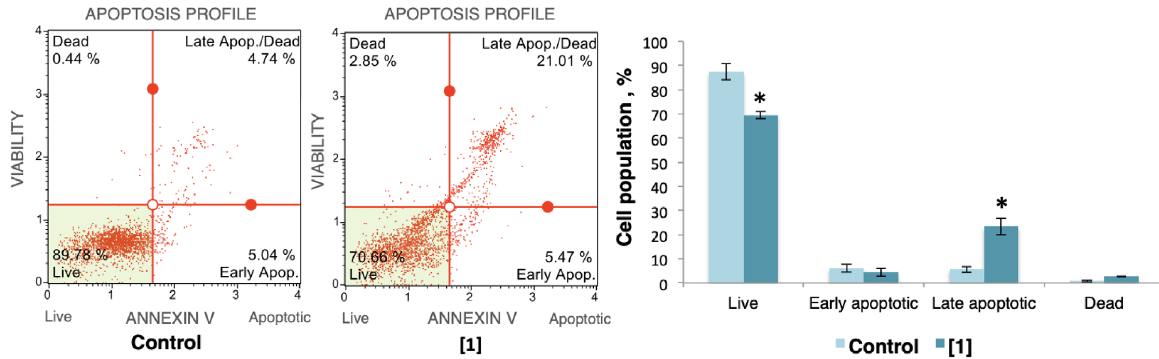
Figure 3. The results of the Annexin V binding assay. The cells were plated in a 12-well plate at a density of 2x10 5 cells/ml and treated with 3.432 mg/mL of hexane extract from the root [1] for 24 hr, and the apoptosis was detected by the Muse cell analyzer (Millipore). Nontreated cells were used as control. The apoptotic cells were determined by the Annexin V positivity based on phosphatidylserine exposure, and dead cells were determined by the nuclear dye 7-AAD (7-aminoactinomycin D) positivity. Four different cell population were enabled to examine by cytofluorometric separation on a Muse cell analyzer: non-apoptotic live (lower left (LL): 7-AAD negative, apoptosis negative), non-apoptotic dead (upper left (UL): 7-AAD positive, apoptosis negative), apoptotic live (lower right (LR): 7-AAD negative, apoptosis-positive), and apoptotic dead (upper right (UR):7-AAD positive, apoptosis-positive) cells. The results were given for three independent experiments, and the differences are * from control